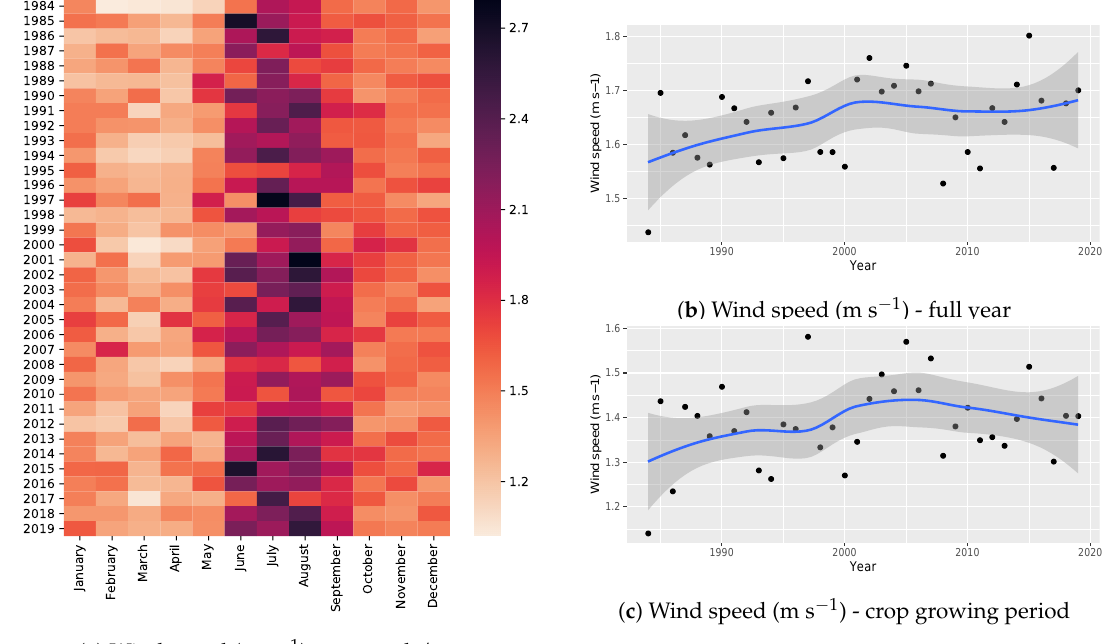
Figure A11. Time series of average wind speed (m s − 1 ) in Loja from 1984 to 2019. ( a ) Heat-map of wind speed (m s − 1 ) per each month and year. The color scale represents the wind speed in m s − 1 . ( b ) Wind speed averaged during the full year. ( c ) Wind speed averaged during the maize crop growing period in Ecuador (January–May). Each dot represents one record, the blue line shows the smoothed time series and the shaded area represents the 95% confidence